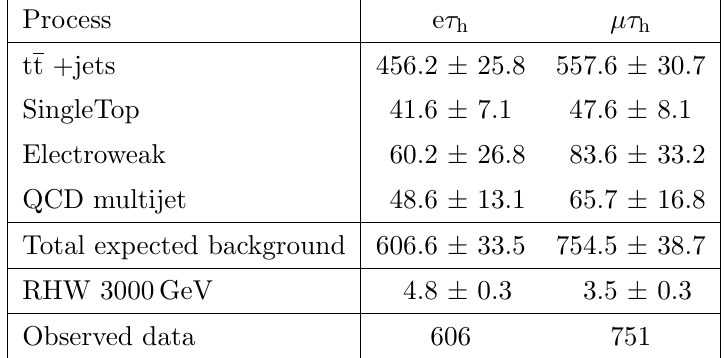
Table 2 . Number of events observed in the e (cid:28) h and (cid:22)(cid:28) h channels of the heavy right-handed W analysis compared to the background expectations and to the event yield expected for a represen- tative right-handed W boson signal of mass 3 TeV. The quoted uncertainties represent the sum of statistical and systematic uncertainties and are obtained by the binned maximum likelihood (cid:12)t of the distribution in S T , as described in the